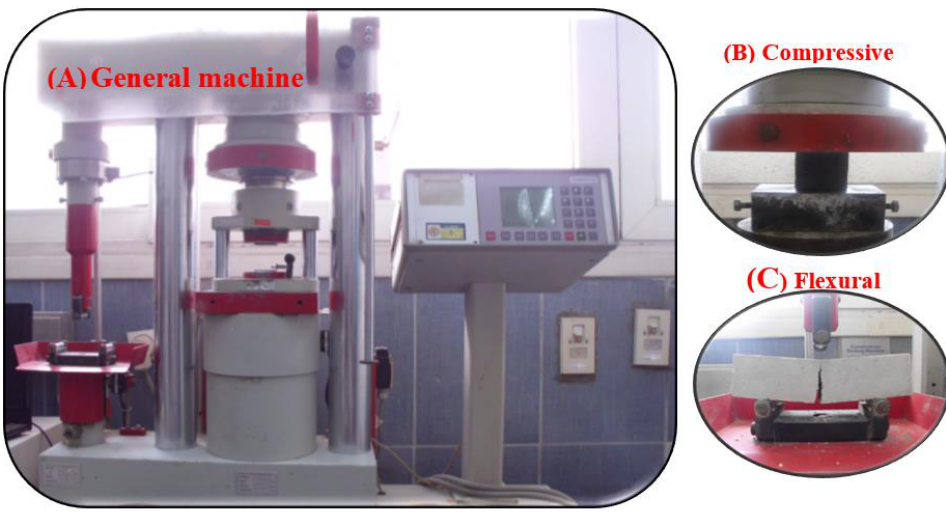
Figure 4. View of testing: ( A ) machine, ( B ) compressive strength, and ( C ) flexural strength.